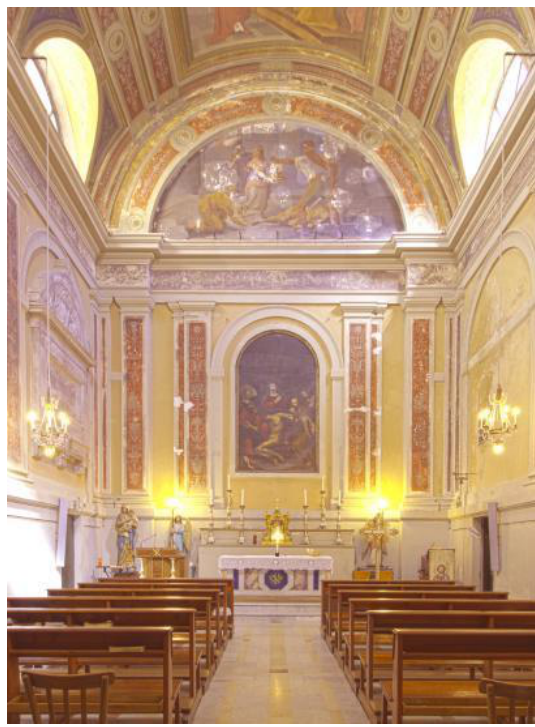
Figure 2. Internal view of the "Chiesa della Pietà" (by Onori